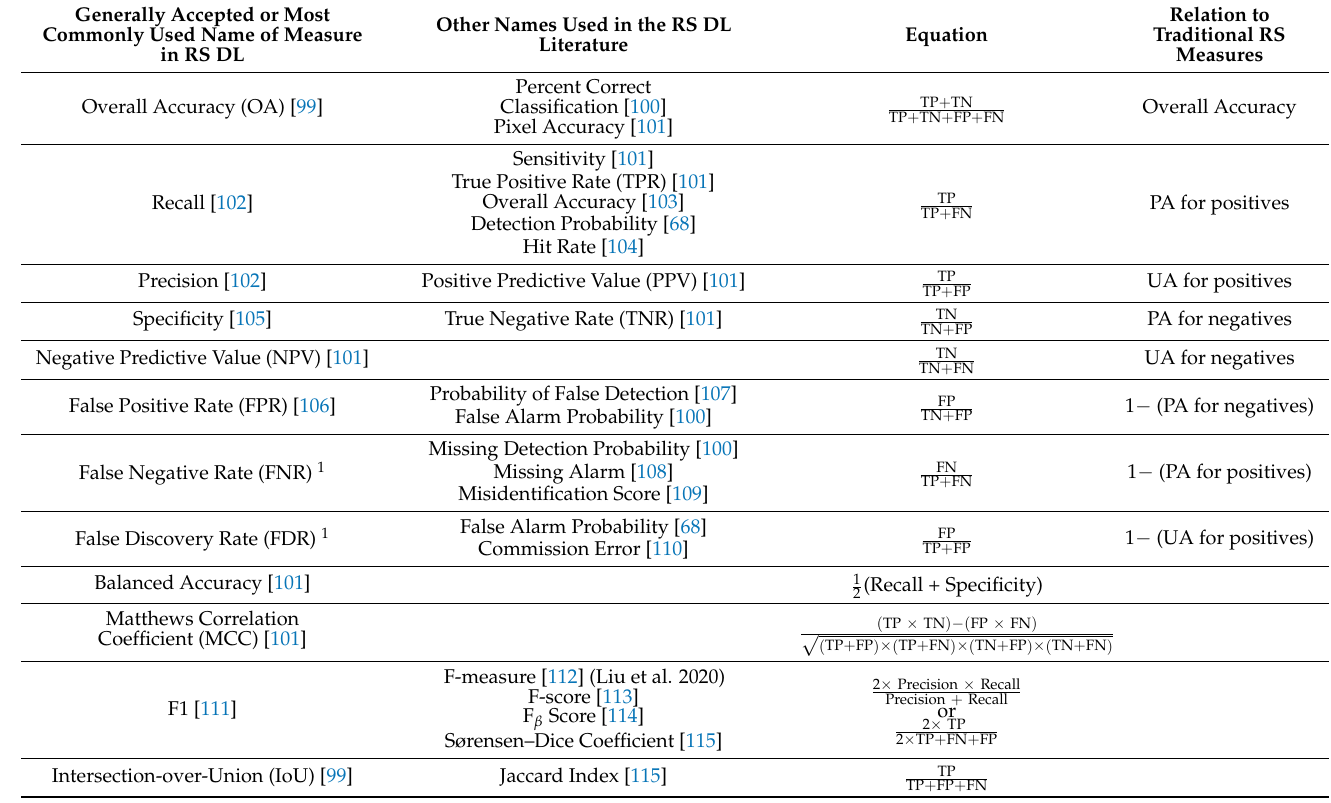
Table 6. Classification accuracy assessment metrics most commonly used in the DL literature, with the associated equation for a binary classification matrix. Citations are from the literature review for illustrative purposes, and are not meant to be